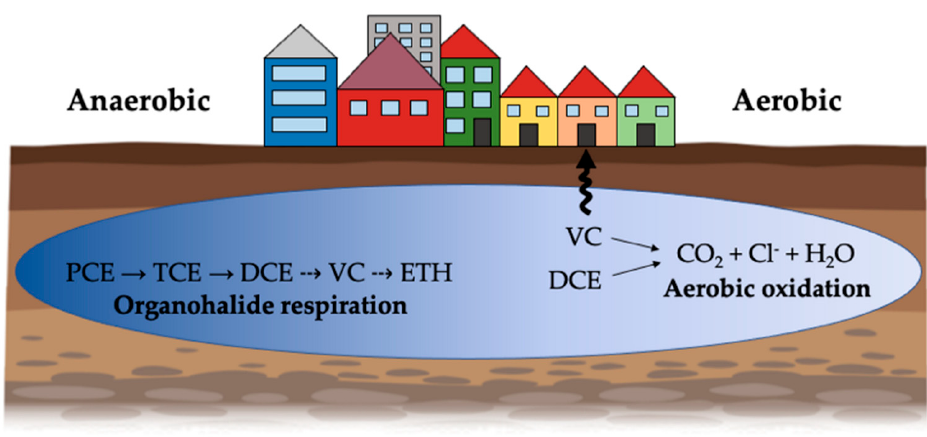
Figure 1. CEs degradation pathways. In the anaerobic portion, there has been incomplete reductive dechlorination with the accumulation of DCE and VC (dashed arrows). Following the aerobic portion permits complete mineralization of the